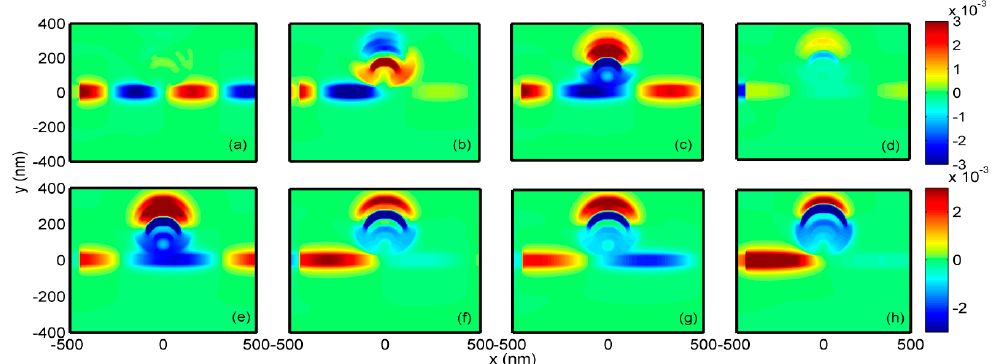
Figure 8. Magnetic field distributions for the six-ring resonator ( a ) peak at 835 nm, ( b ) dip at 1015 nm, ( c ) peak at 1070 nm, ( d ) dip at 1275 nm, ( e ) peak at 1348 nm, ( f ) dip at 1556 nm, ( g ) peak at 1623 nm and ( h ) dip at 1960 nm.